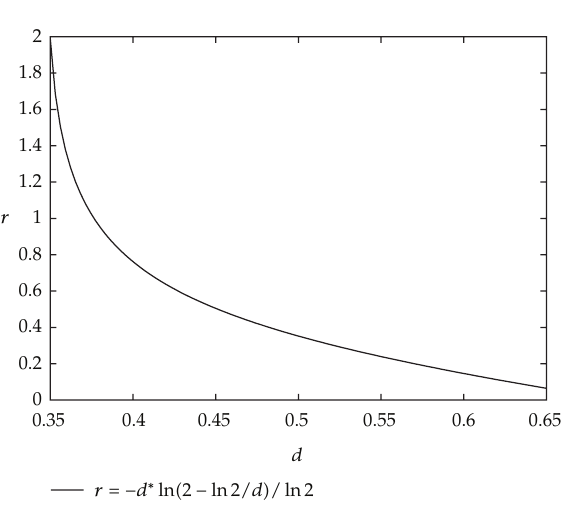
Figure 1: The domain of values (cid:2) d,r (cid:3) satisfying inequality (cid:2) 2.47 (cid:3) . If the values of advances d and r are under the curve, then (cid:2) 2.44 (cid:3) has a positive